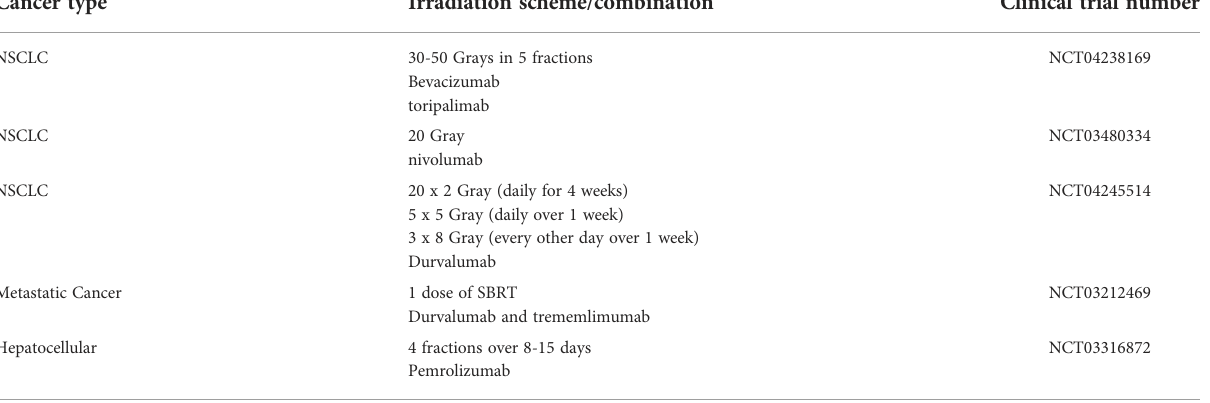
TABLE 3 Select ongoing clinical trials involving radiotherapy and checkpoint inhibitors to achieve abscopal